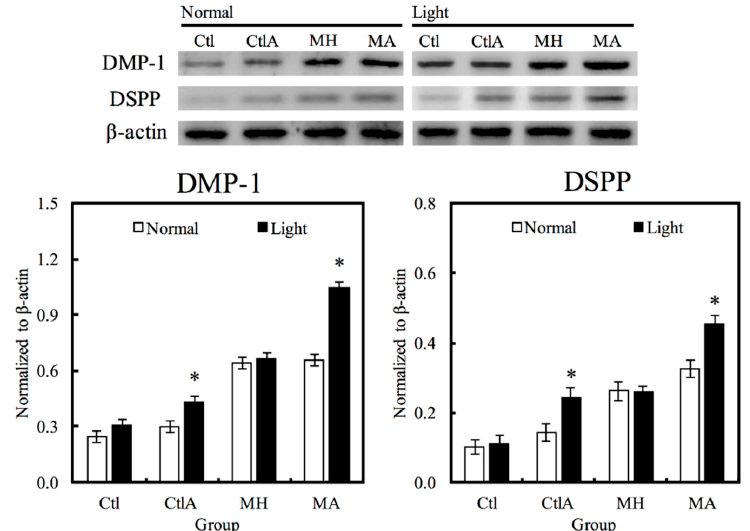
Figure 4. Western blot analysis of hDPCs protein expression (DSPP and DMP-1) cultured on MTA-ALA after 7 days of culture with red light treatment “*”, with a significant difference ( p < 0.05) from specimens without red light treatment.